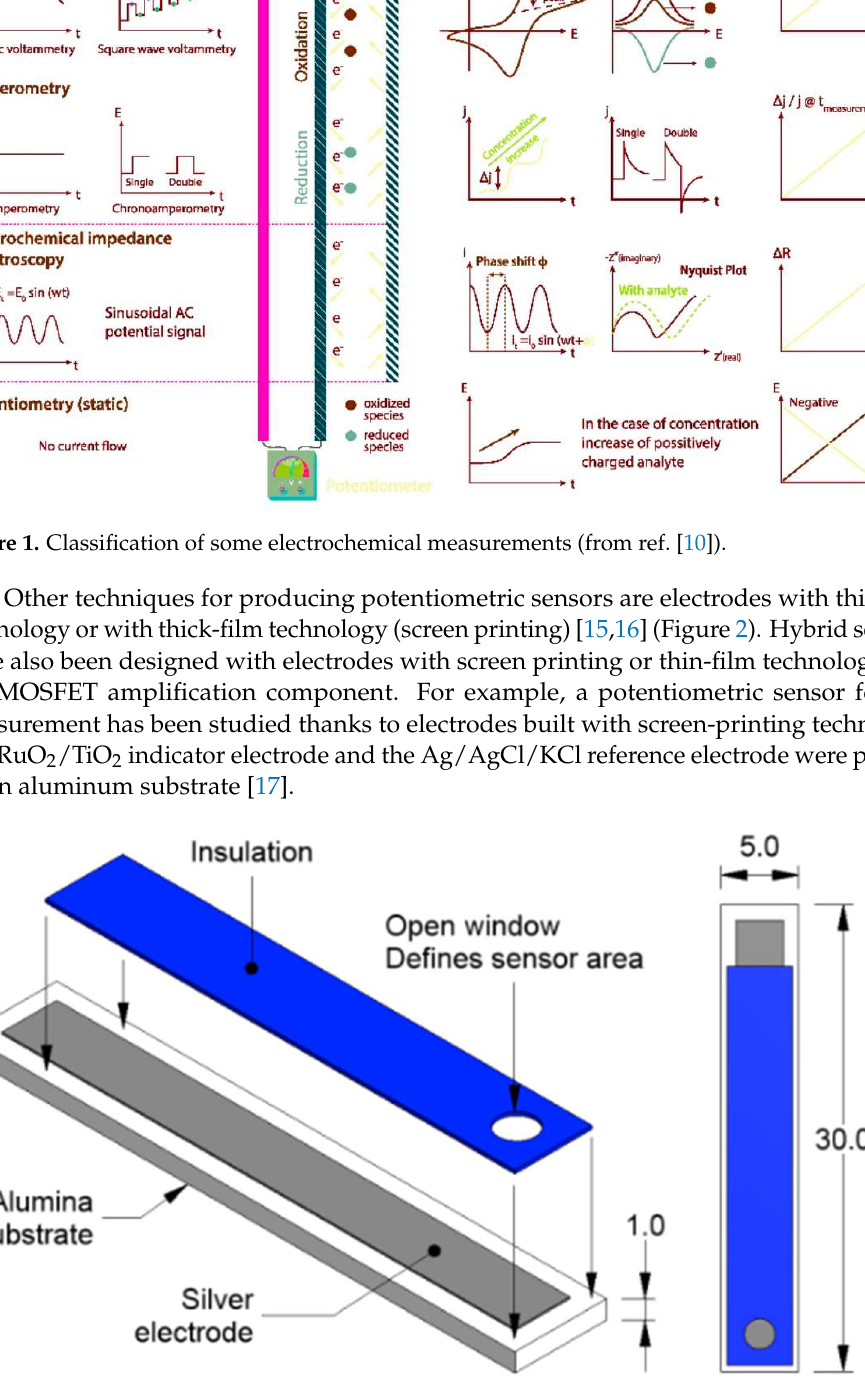
Figure 2. Schematic of a single potentiometric chloride sensor composed of a number of screen- printed layers (from ref. [15]).